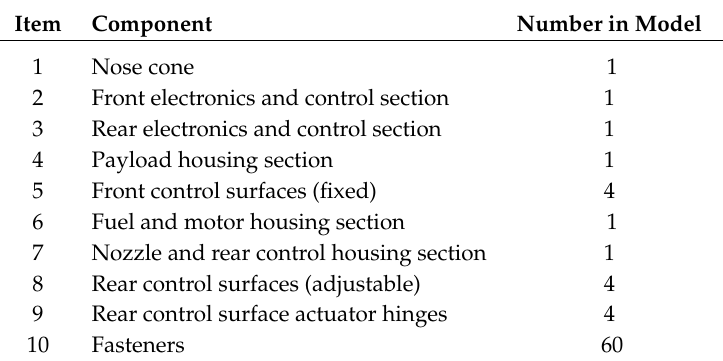
Table 3. AIM-120 AMRAAM airframe components.